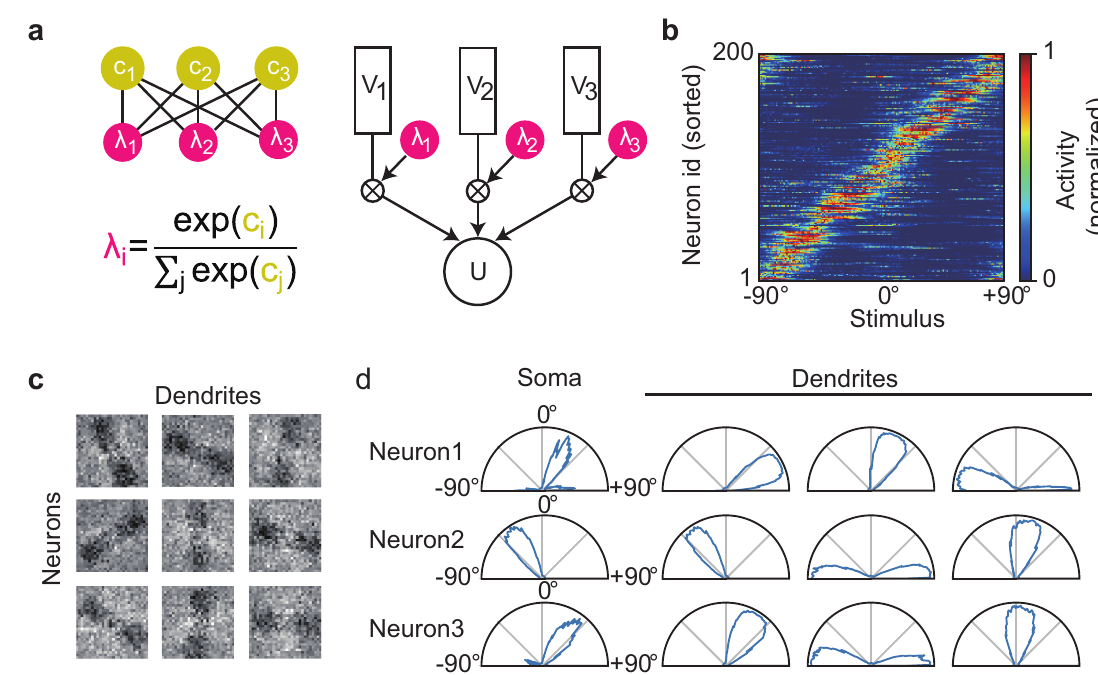
Fig 7. Redundant dendritic representations of preferred sensory features. (a) A schematic illustration of the neuron model with three dendritic compartments. The dendritic branches have independent gating factors, which compete with each other by softmax. (b) Somatic responses are shown for all neurons in the trained network. (c) Trained weight matrices are displayed for afferent inputs to three dendritic branches of three example neurons. (d) Somatic and dendritic activities of the three neurons in (c) are shown.